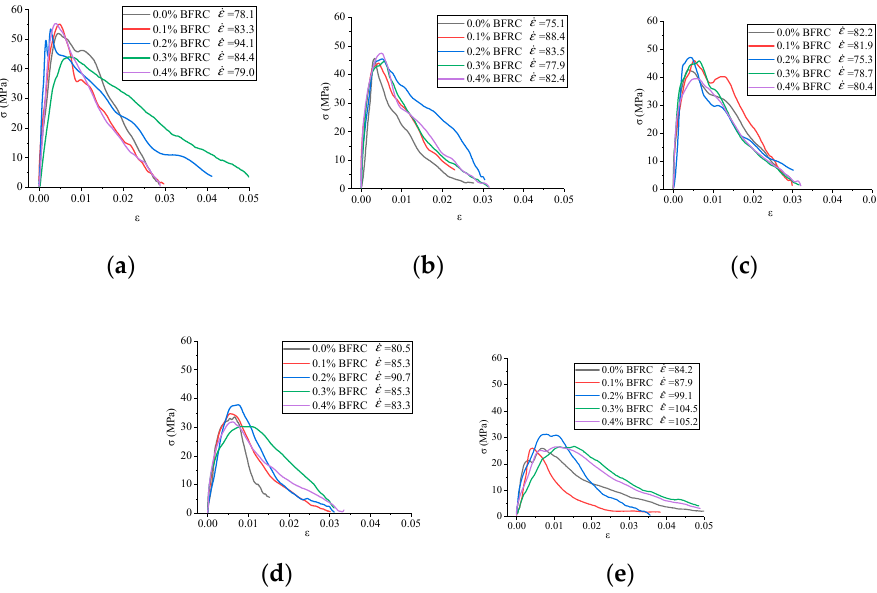
Figure 2. The stress–strain curves of basalt fiber reinforced concrete (BFRC) for different fiber contents and temperatures when the impact velocity is 8.8 m/s. ( a ) Temperature: 20 °C; ( b ) temperature: 200 °C; ( c ) temperature: 400 °C; ( d ) temperature: 600 °C; and ( e ) temperature: 800 °C.